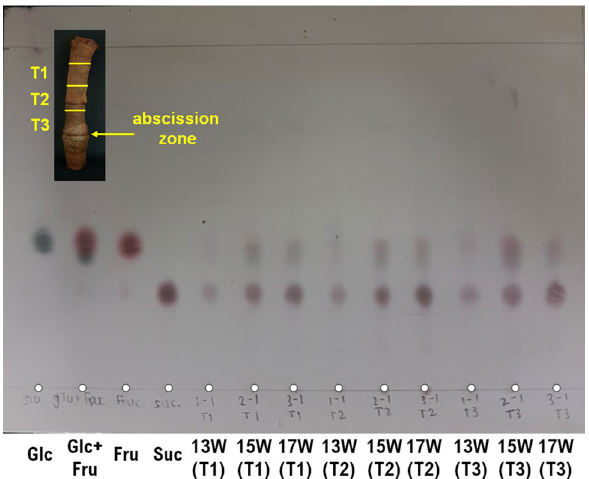
Figure 2. Thin layer chromatogram (TLC) of standard sugar solutions (glucose, glucose and fructose, fructose, and sucrose respectively), and liquid extracts from the peduncle of 13 W, 15 W and 17 W (with T1, T2 and T3 as different portions measured from the abscission